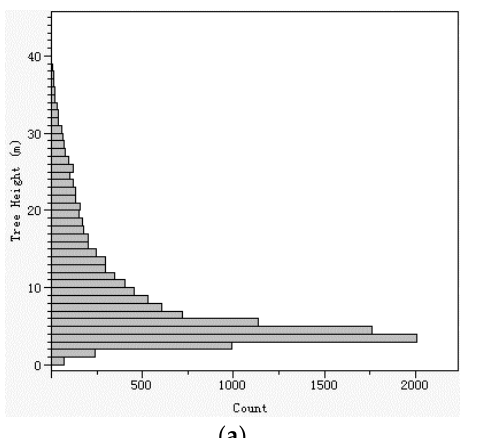
Table 1. Main technical parameters of LiteMapper 5600